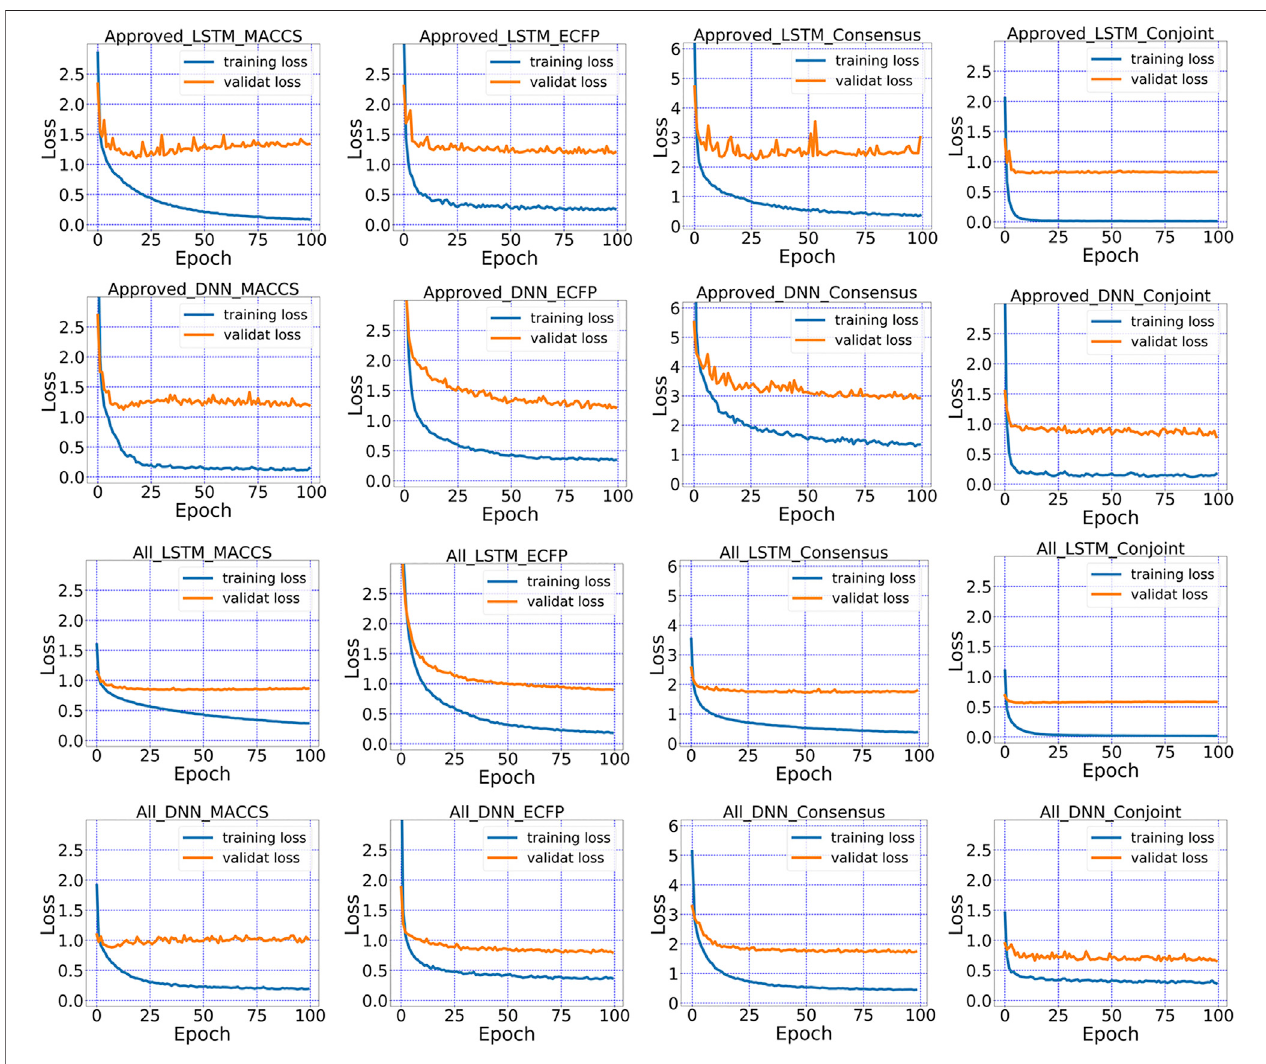
FIGURE 7 | The loss in the training and validation dataset for MACCS keys, ECFP, the conjoint fi ngerprints.